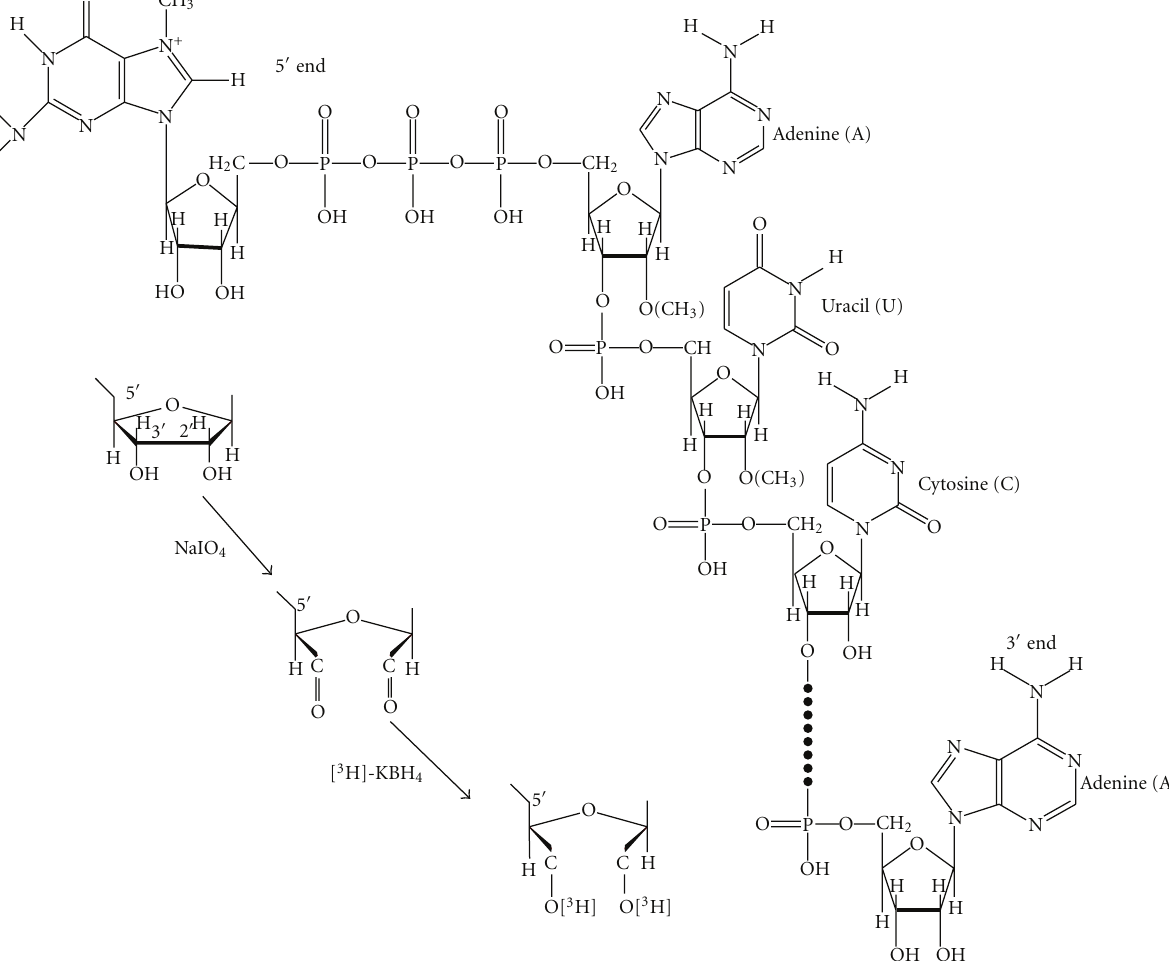
Figure 12: RNA 5 (cid:2) and 3 (cid:2) end labeling with [ 3 H] by treatment with NaIO 4 and [ 3 H]-KBH 4 . The 4–7S RNA from Noviko ff hepatoma cell nuclei was labeled to detect the presence of free 2 (cid:2) -OH and 3 (cid:2) -OH by NaIO 4 oxidation followed by [ 3 H]-KBH 4 reduction. The reaction occurred at both ends of RNA (5 (cid:2) end and 3 (cid:2)